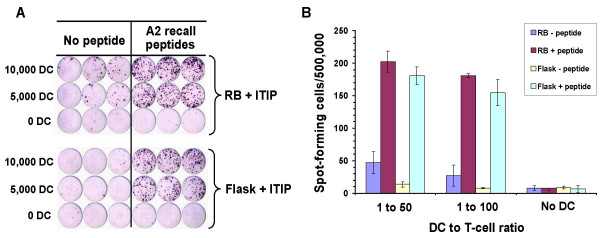
Dendritic cells generated in roller bottles stimulate autologous peptide-specific T-cell responses. Dendritic cells from HLA-A*0201+ normal donor leukopheresis products were differentiated and matured with ITIP in roller bottles or static flasks as before. The floating cells were harvested, pooled, irradiated (20 Gy), and pulsed with HLA-A*0201 epitopes from flu, EBV, and CMV (see Materials and Methods for details). The DC were washed and added to 500,000 T-cell-enriched autologous PBMC in anti-IFN-γ antibody-coated ELISPOT plates in the numbers indicated. Each assay was run in triplicate. The plates were harvested after overnight culture and developed. Shown is the image taken of the developed ELISPOT plate (A) and corresponding graphical representation of the number of spots per 500,000 input responder cells under the different conditions (B). Dendritic cells without peptide pre-pulsing were used as controls. The results are representative of two similar experiments.